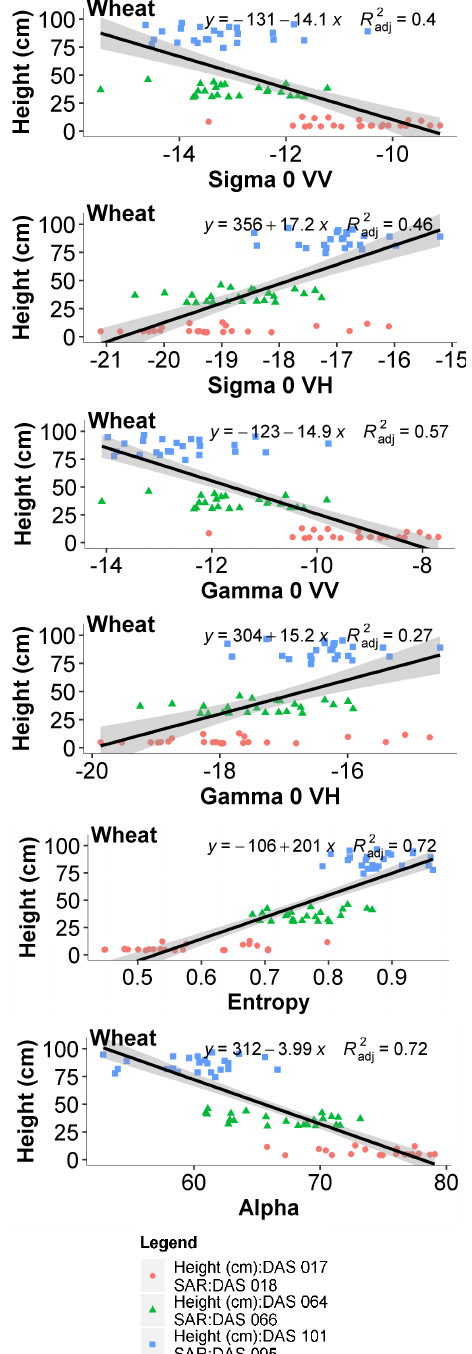
Figure 7. Relationship between Height and Sigma, Gamma, Entropy and Alpha angle for wheat.